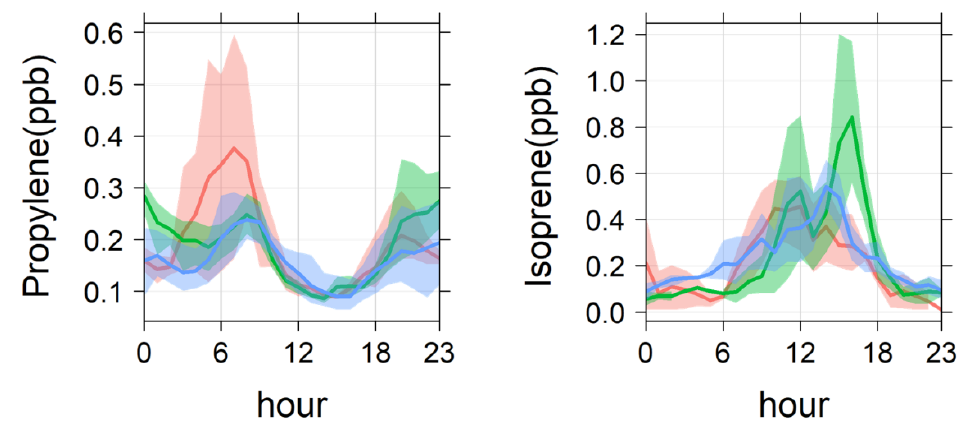
Figure 8. Diurnal variation in alkenes, ethylene, propylene and isoprene at the ZH site. The solid line represents the mean value, and the filled area indicates the 95% confidence intervals in the mean.